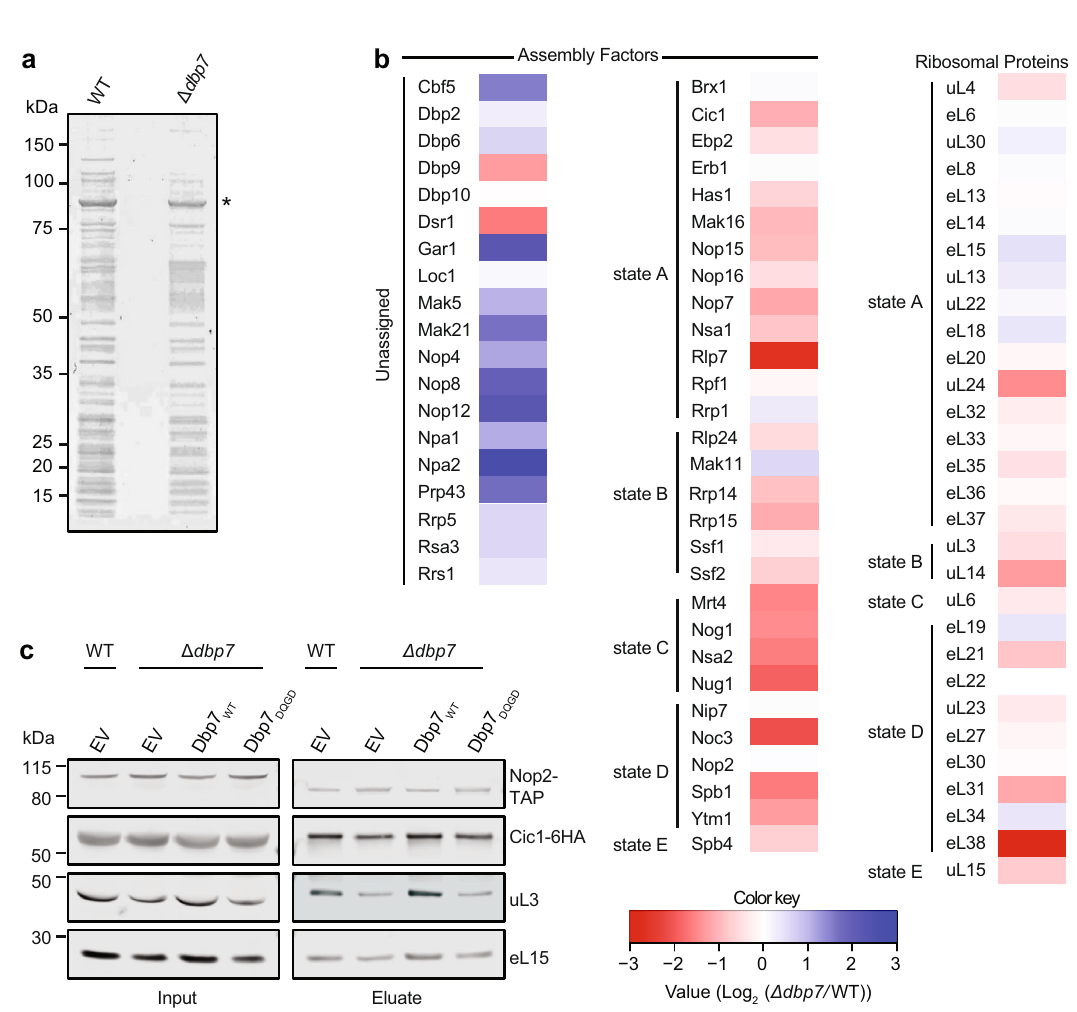
Fig. 5 A subset of snoRNAs accumulate on pre-60S particles in the absence of Dbp7. a The fold enrichments of snoRNAs showing >two-fold enrichment in Dbp7-HTP_2 PAR-CRAC dataset compared to WT_2 are shown. b Whole-cell extracts from wild-type yeast (WT) containing an empty vector (EV) and the Δ dbp7 strain carrying EV or plasmids for expression of Dbp7 WT or Dbp7 DQGD were separated by sucrose density gradient centrifugation. RNAs extracted from each fraction were separated by denaturing PAGE and the distributions of the indicated snoRNAs were analyzed by northern blotting. Where snR63 and snR82 are simultaneously detected, the lower band corresponds to snR63 and the upper to snR83. Experiments were performed in duplicate and representative data is shown. c Extracts from yeast strains expressing Nop2-TAP in the background of the Dbp7 complementation system were used for pulldowns on IgG sepharose. RNAs present in inputs (3%) and eluates were extracted, separated by denaturing PAGE and the indicated snoRNAs detected by northern blotting. Experiments were performed in duplicate and representative data is shown. d Equal numbers cells from the